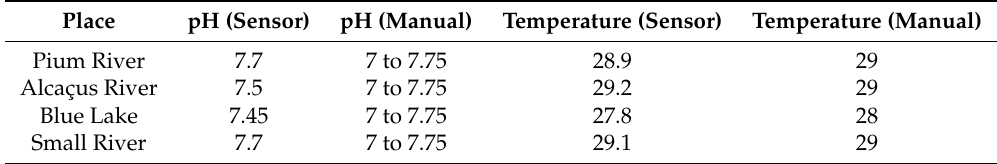
Table 2. Comparison betweeen manual manual and sensors kit